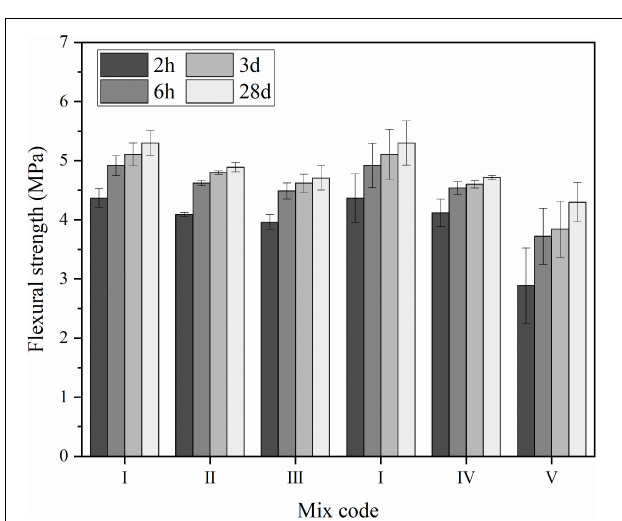
FIGURE 5 | 28 days elastic modulus of